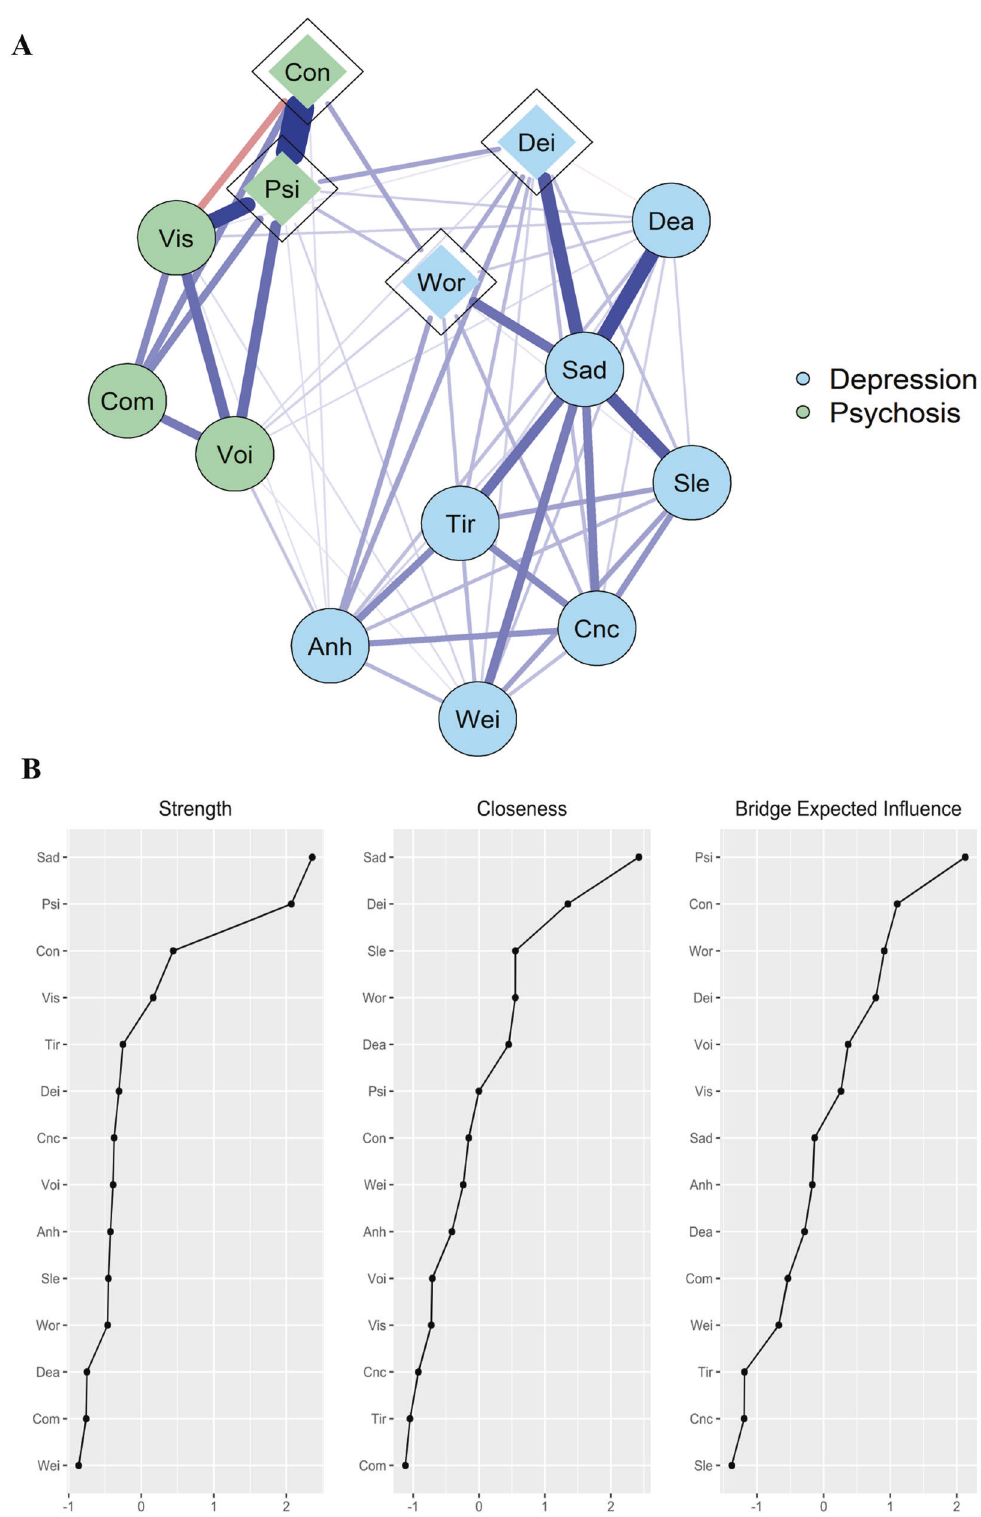
Fig. 1 Network of depression and psychosis symptoms in the UK Biobank study. A Symptom groups are represented with different colors; bridge nodes are depicted with a diamond shape. Edges (lines) can be interpreted as partial correlations, with edge thickness representing the strength of the correlation. Blue edges represent positive associations; red edges represent negative associations. B Centrality indices and bridge expected in fl uence index for Step-1 network. Anh = anhedonia; Cnc = dif fi culty concentrating; Com = beliefs in unreal communications; Con = beliefs in unreal conspiracy against self; Dea = thoughts of death; Dei = depression impairment; Psi = psychosis impairment; Sad = feelings of sadness/depression; Sle = sleep changes; Tir = feelings of tiredness; Vis = seeing unreal visions; Voi = hearing unreal voices; Wei = weight change; Wor = feelings of worthlessness